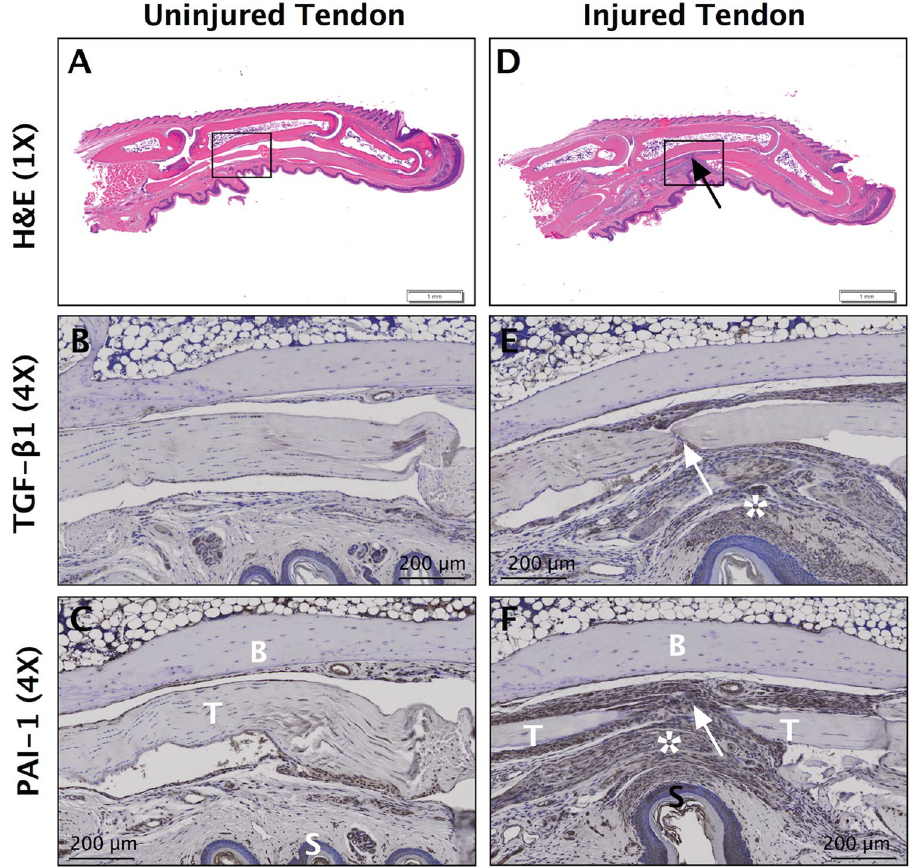
Figure 2. TGF- β 1 and PAI-1 are abundant in injured mouse flexor tendon adhesions. Sagittal sections of uninjured ( A – C ) and Zone II partially-lacerated ( D – F ) deep digital flexor tendons at 14 dpi. Sections are stained using hematoxylin and eosin ( E and H ) and antibodies against TGF- β 1 and PAI-1. Arrows indicate the laceration site. Box in D shows the adhesions surrounding the injured tendon (magnified in E and F ). Asterisks in E and F highlight the intense brown staining indicative of increased TGF- β 1 and PAI-1, respectively, in the adhesions (scar tissue). B = bone, T = tendon, and S =